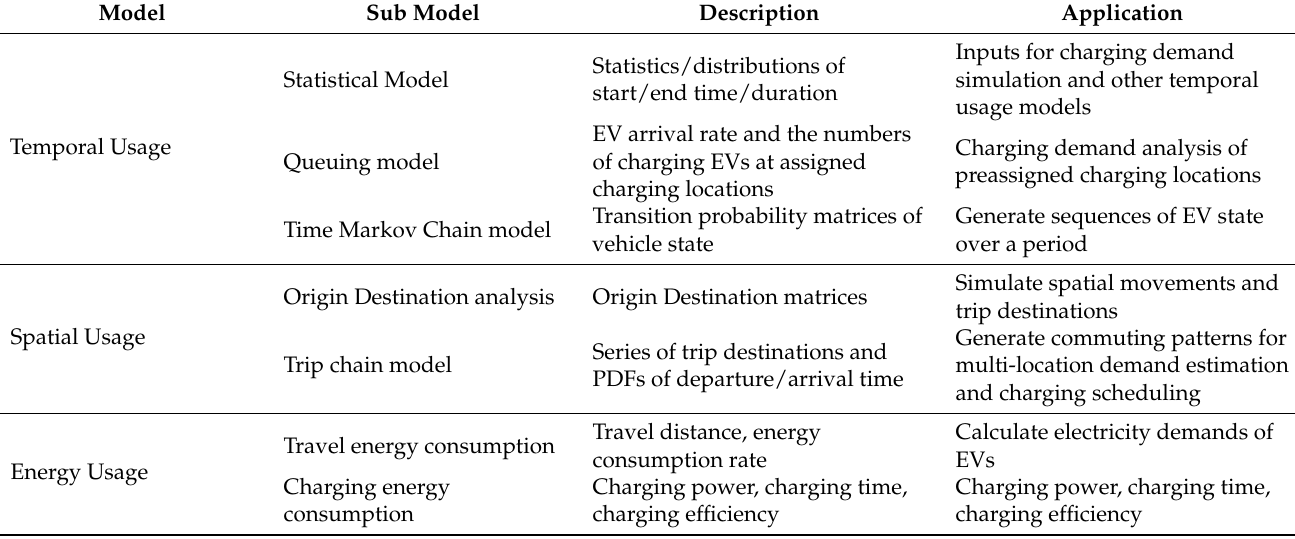
Table 2. Summary of EV usage pattern models